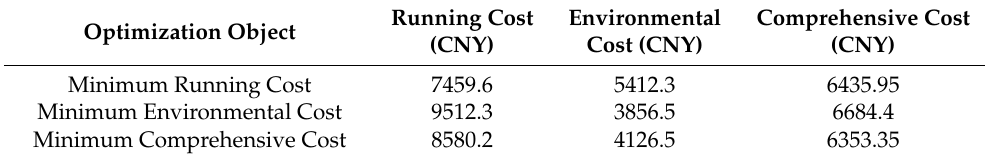
Table 13. Comparison of optimization results of different schemes for a typical day in